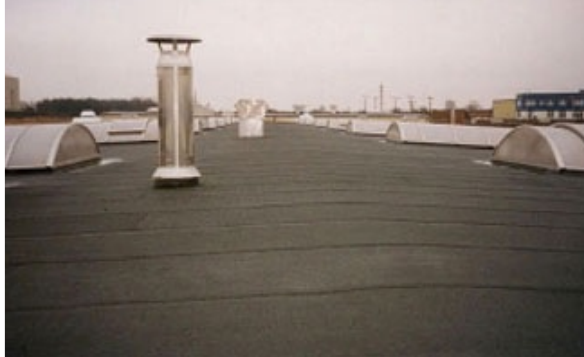
Figure 1: The view of the roof area with an area of 1000m 2 selected for conducting this